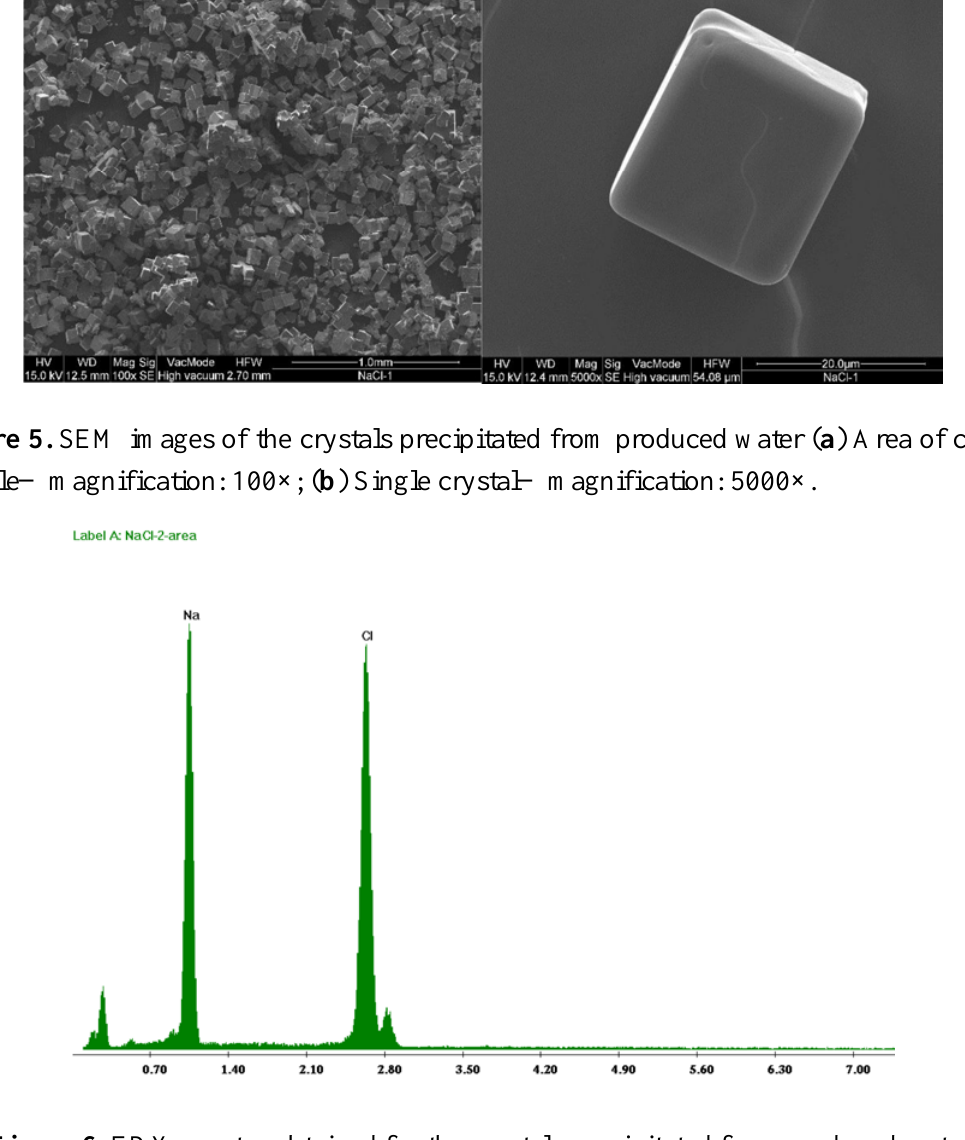
Figure 6. EDX spectra obtained for the crystals precipitated from produced